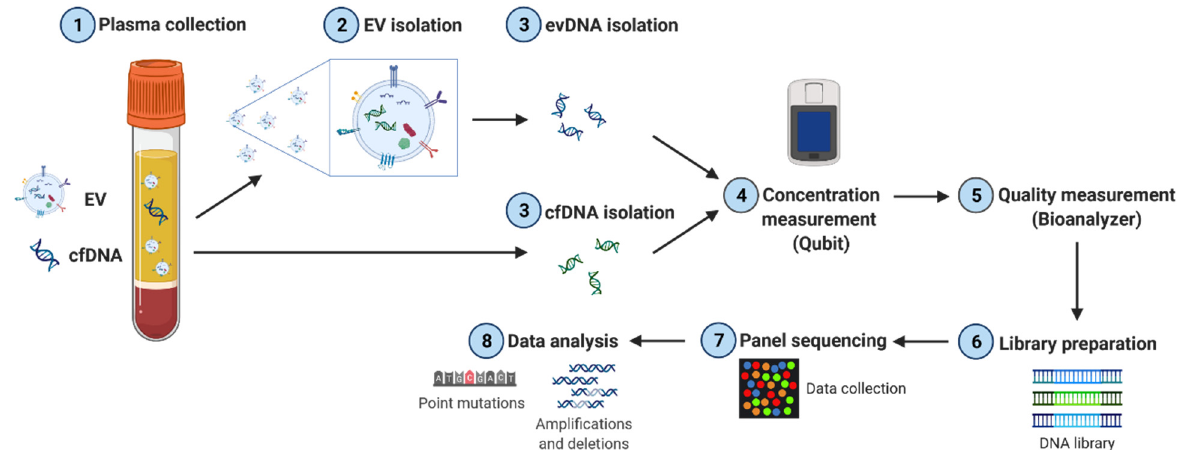
Figure 1. Experimental workflow of sample and data processing. EVs were isolated from PDAC patient plasma by precipitation. ev- and cfDNA were prepared and DNA quality as well as fragment length were determined using a bioanalyzer device. Sequencing was performed using a commercial panel covering 766 tumor-relevant genes.